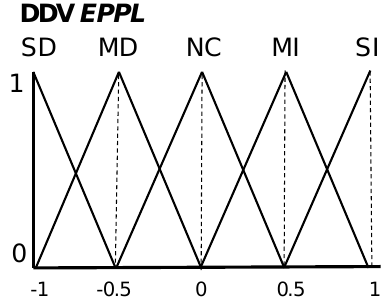
Figure 4. Domain of definition of the variable EPPL